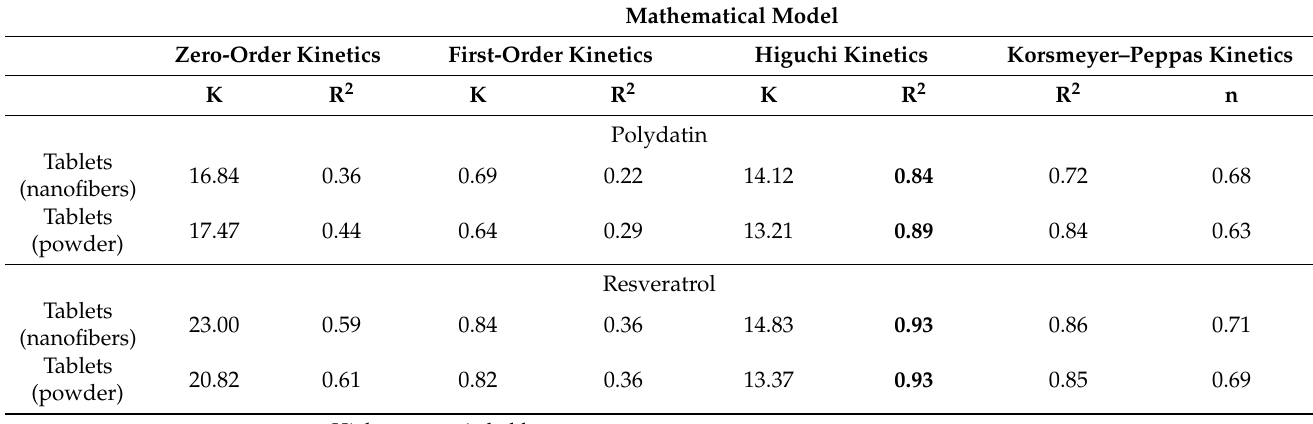
Table 2. Mathematical models of release kinetics of polydatin and resveratrol.